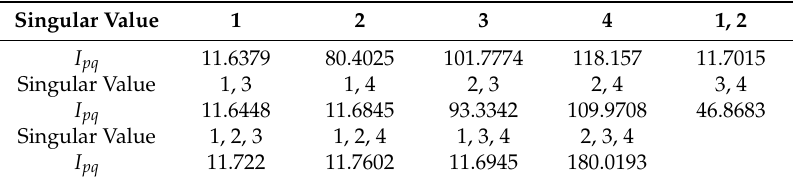
Table 6. Table 6. Statistics information criteria value. Table 6. Statistics information criteria value. Table 6. Statistics information criteria